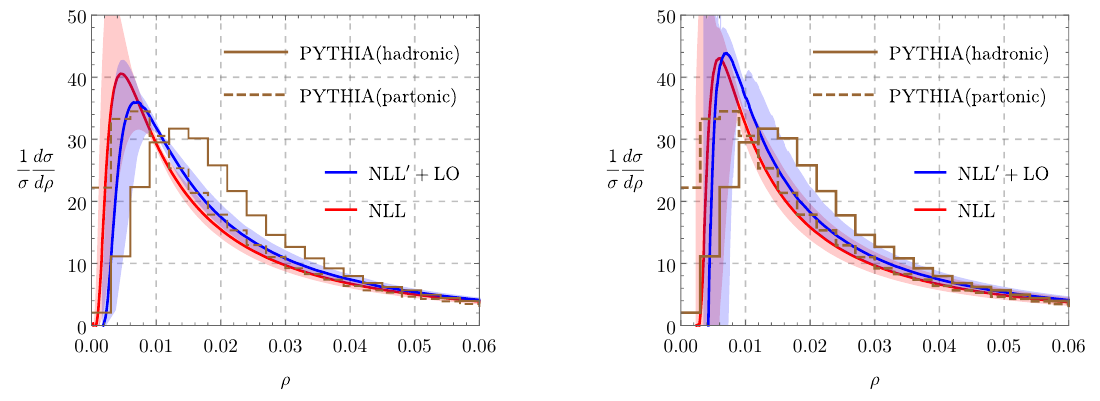
Figure 9 . Jet-mass distribution compared to PYTHIA results. On the left side we plot our default result, based on using the pro(cid:12)le scale (4.3) and exponentiating the matching corrections. On the right-hand side, we do not perform these modi(cid:12)cations such that we get a negative cross section at low (cid:26) and hit the Landau pole at a nonzero (cid:26)